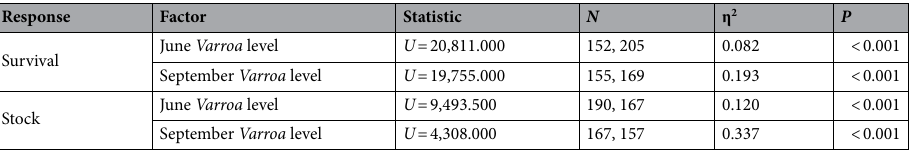
Table 3. Summary statistics for Mann–Whitney U -tests comparing predictive differences in Varroa levels. Eta-squared values indicate factor effect sizes (small, η 2 ≥ 0.010- < 0.060; intermediate, η 2 ≥ 0.060- < 0.140; large, η 2 ≥ 0.140).